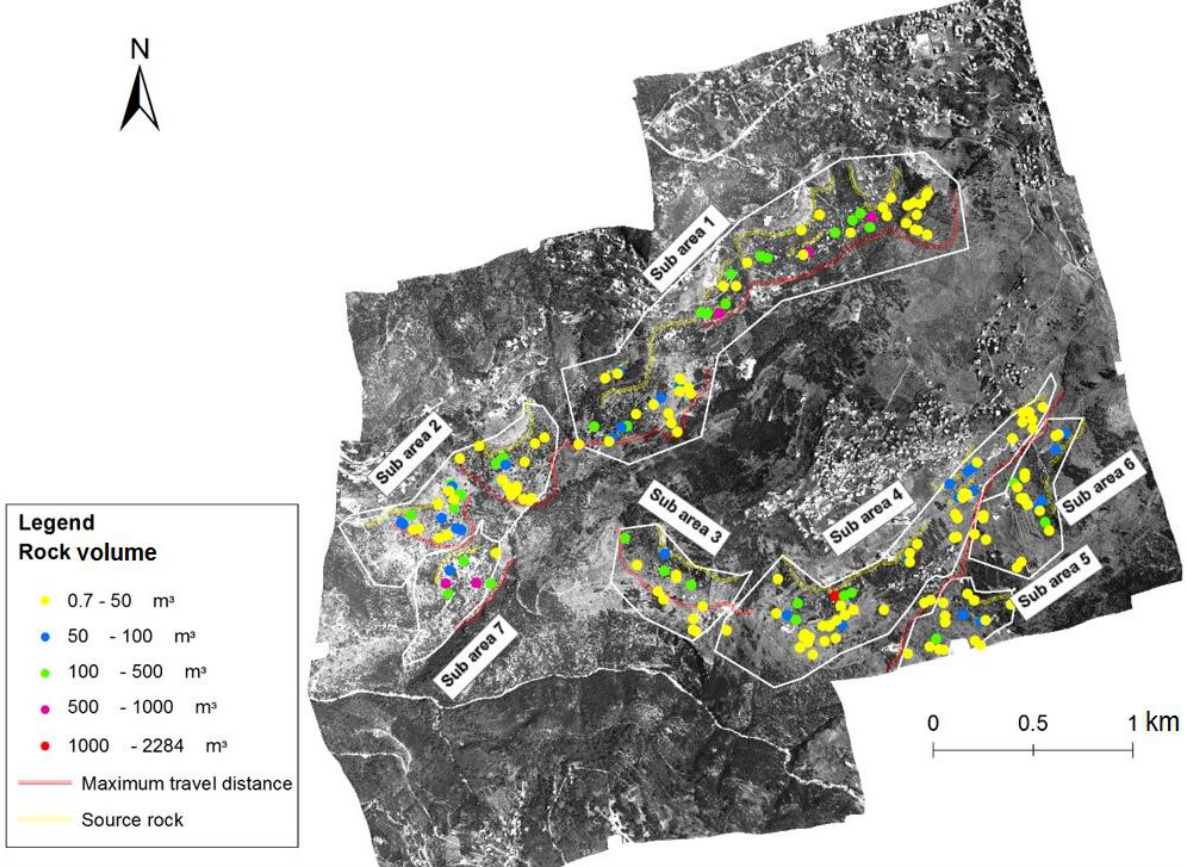
Figure 6. Map of the past falling